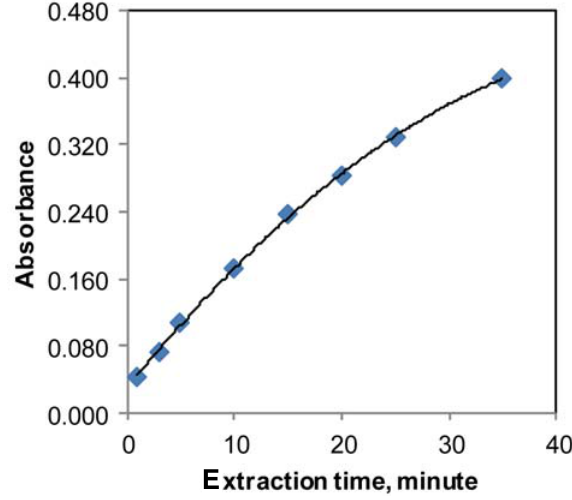
Figure 4. Extraction time effect on the absorbance at 11.5 mL/min flow rate and 10 mL sample volume, concentration of the